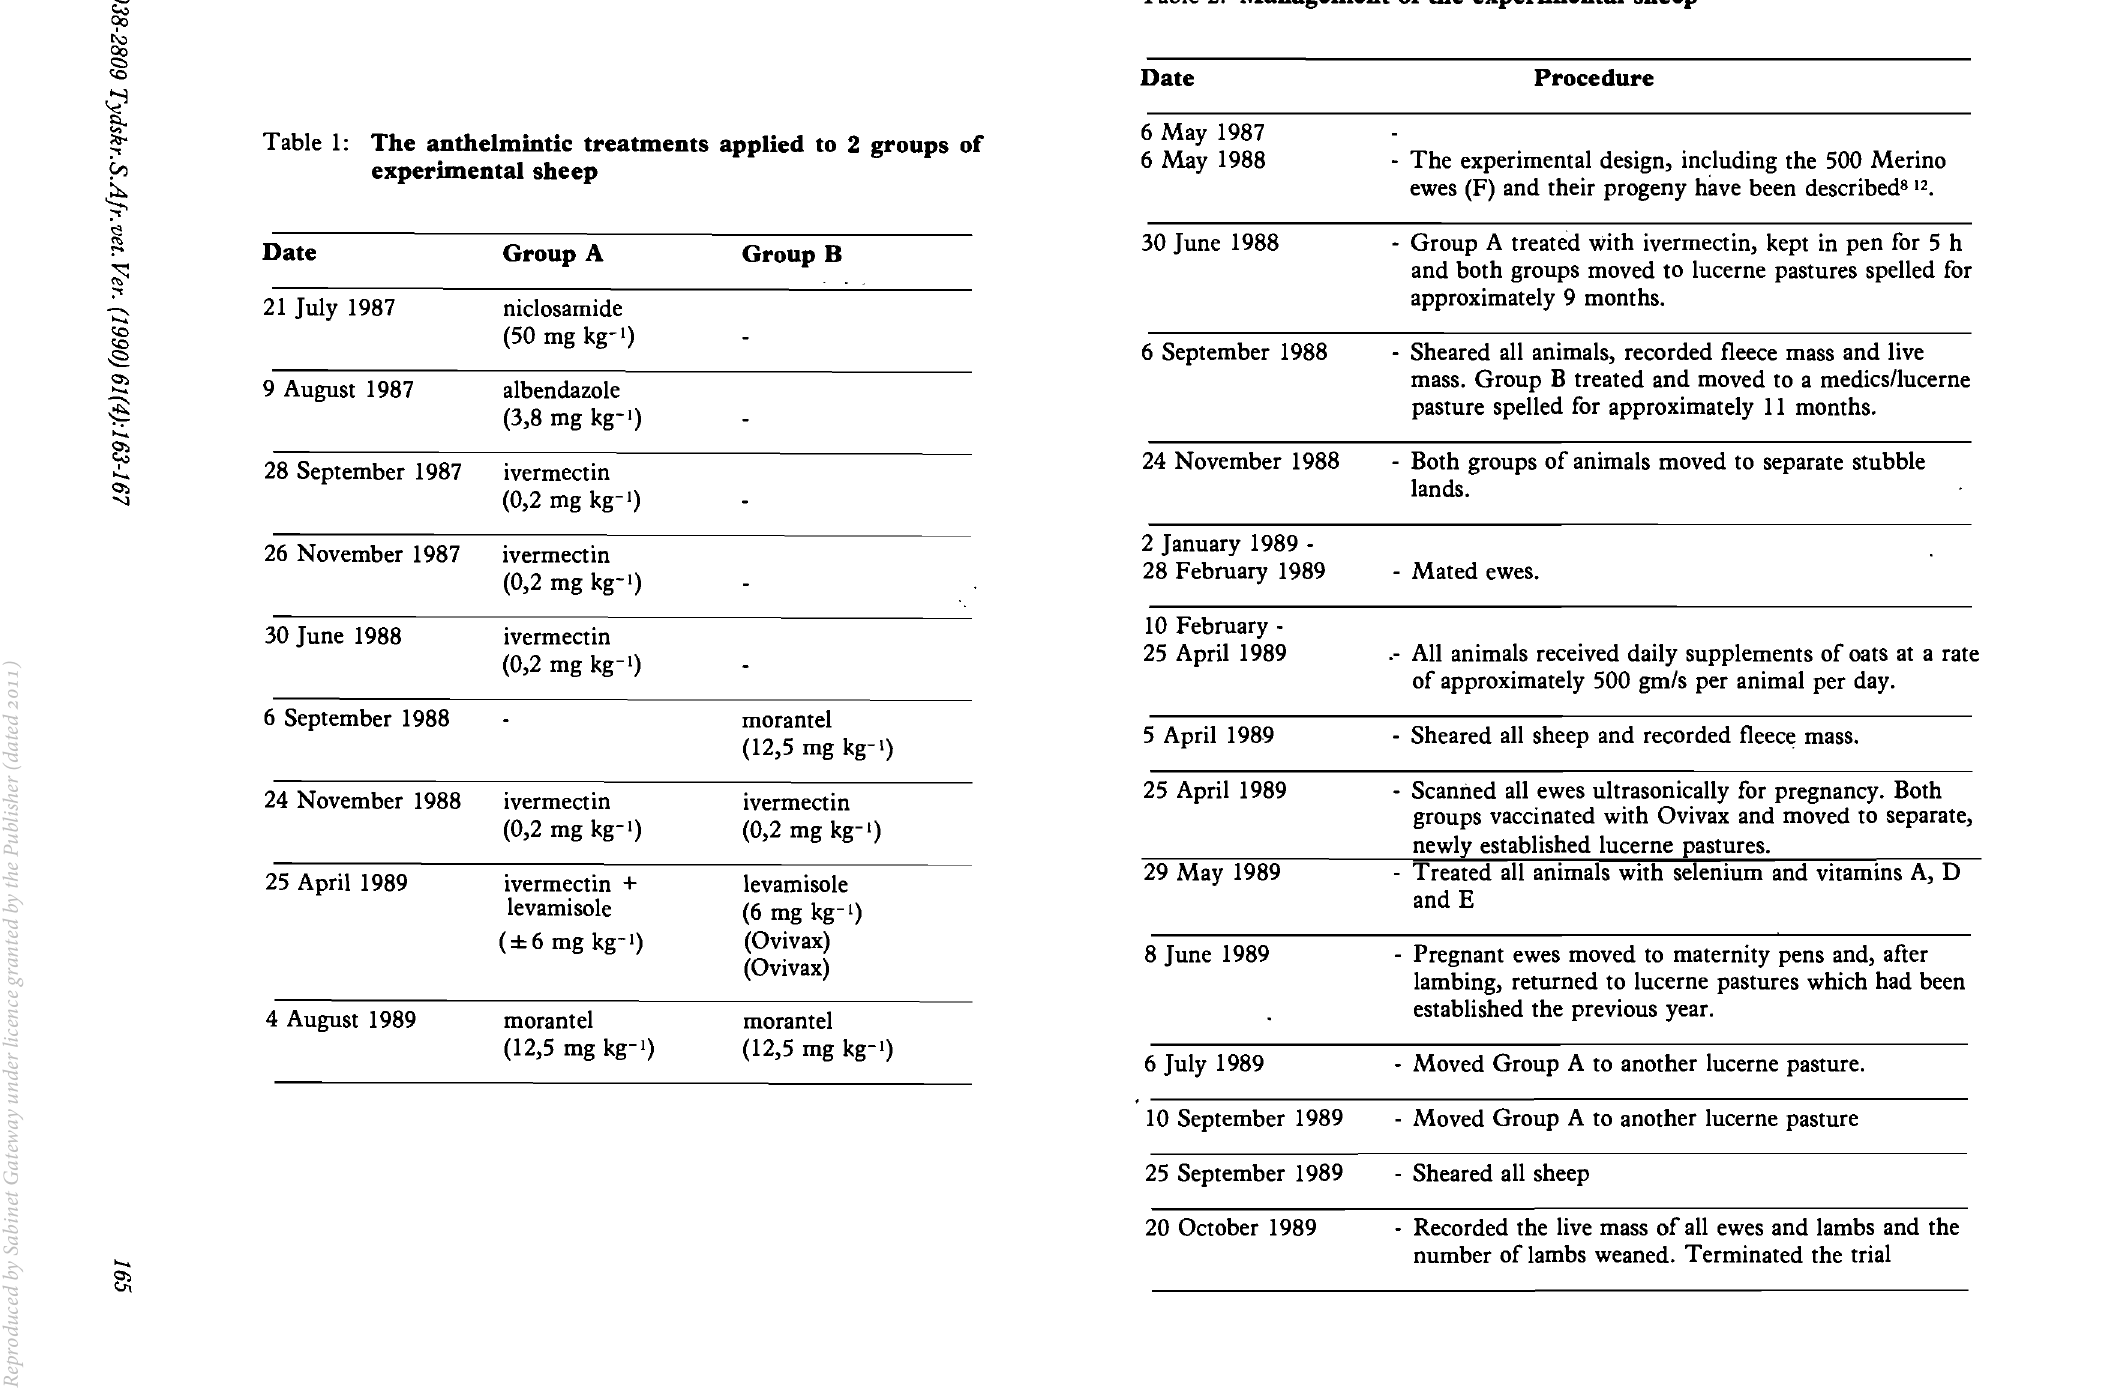
Table 2: Management of the experimental